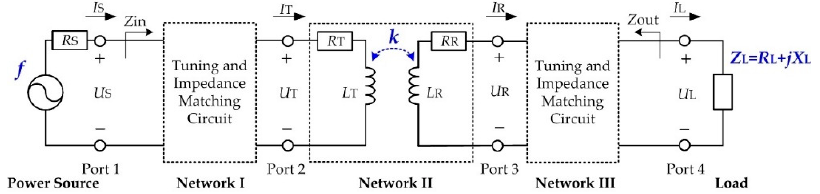
Figure 2. Cascade two-port network model of the WPT system.